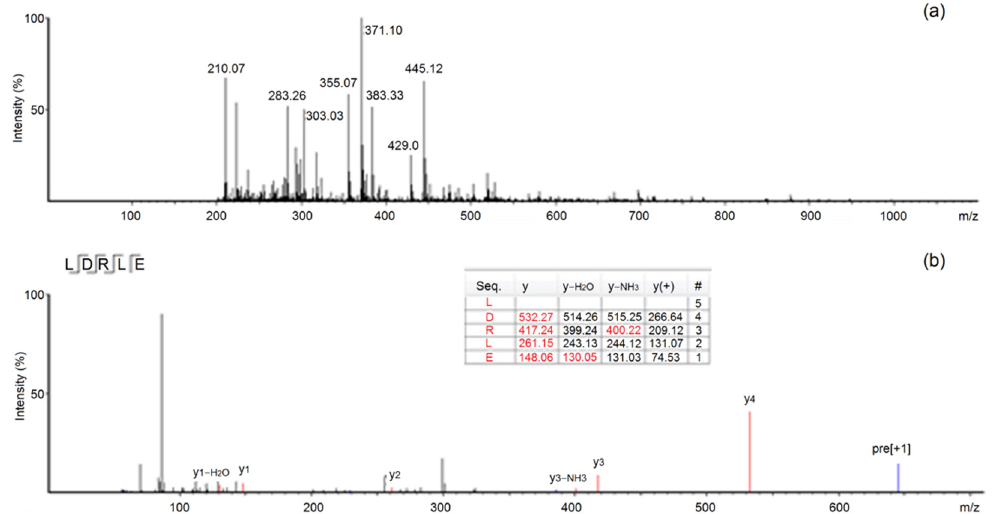
Figure 3. The primary ( a ) and secondary ESI-MS/MS spectra ( b ) of peptide LDRLE identified in sweet almond expeller amandin hydrolysates.